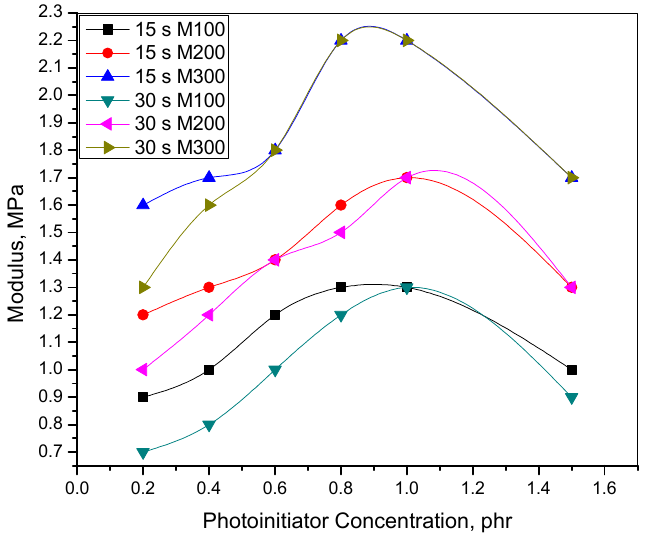
8 of 19 Figure 4. Elongation at break as a function of photoinitiator concentration.